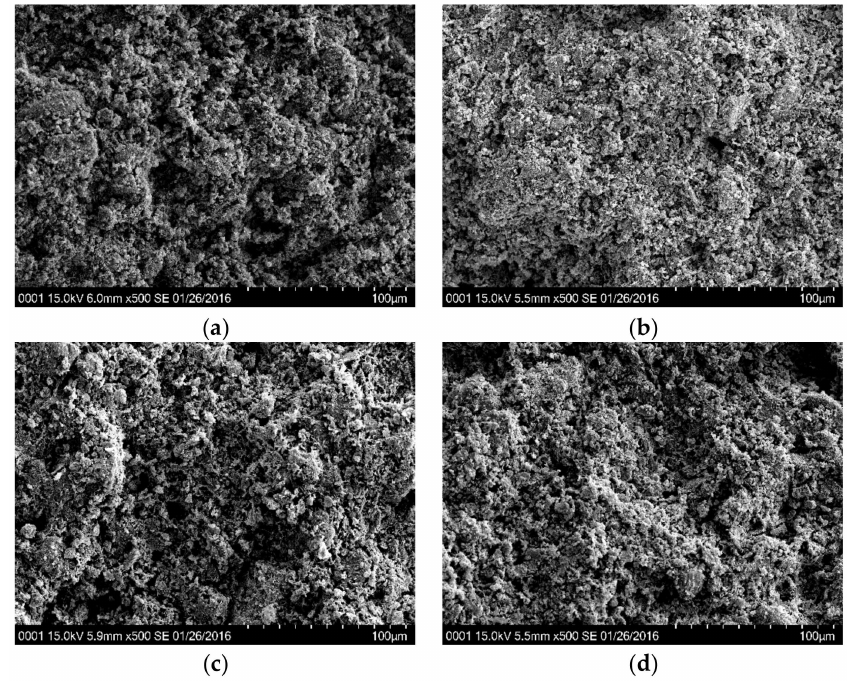
Figure 8. The SEM images of samples magnified 500 times. ( a ) KMicro + 0%; ( b ) KMicro + 5%;